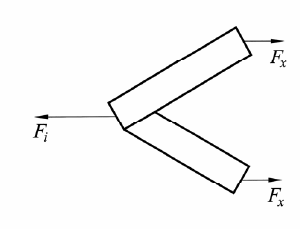
Fig 3. Free body diagram of the forces